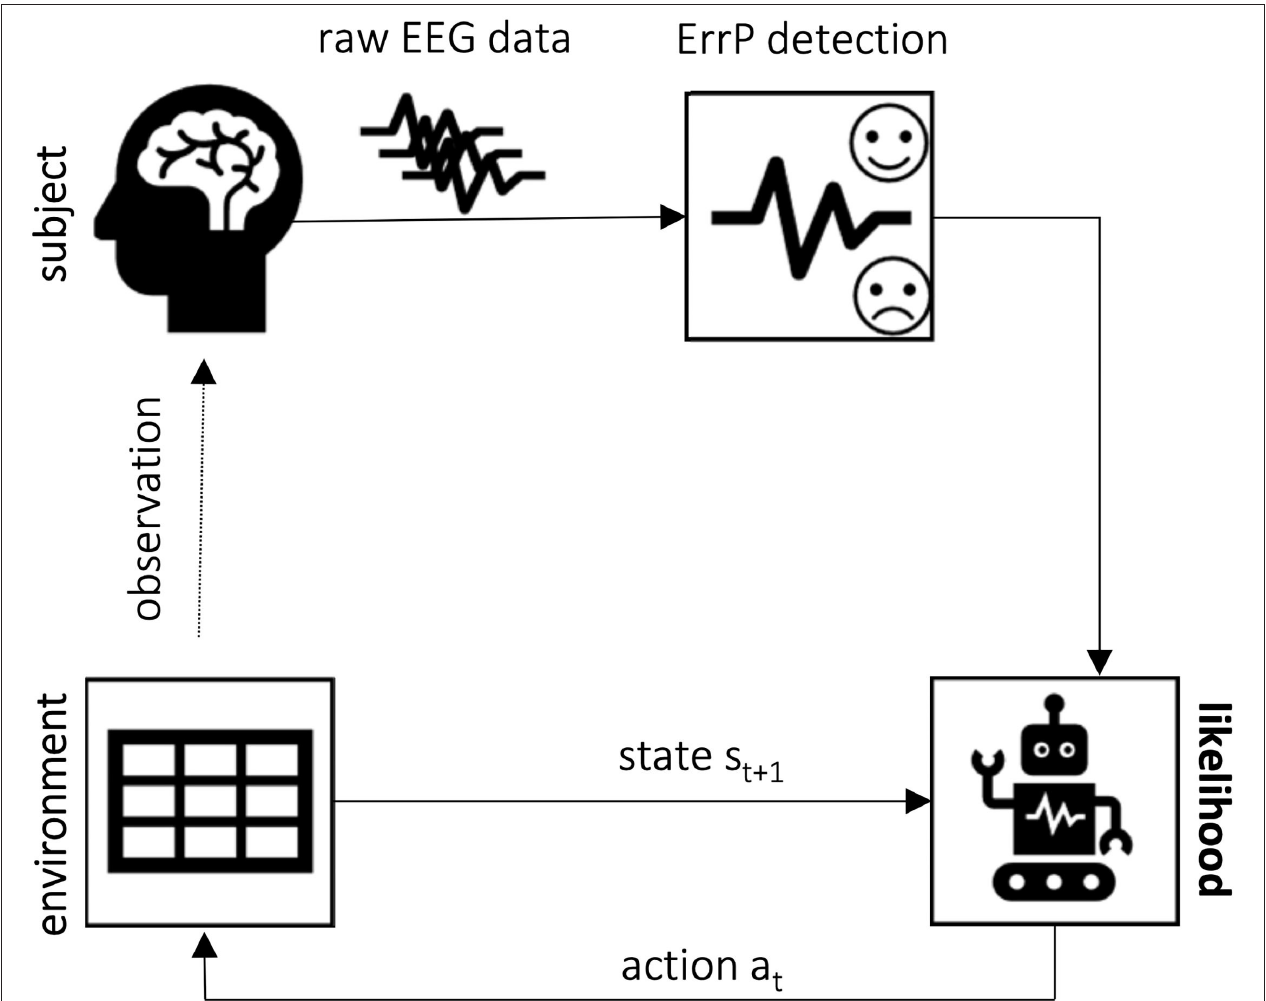
FIGURE 4 | Error-based learning framework concept: upon EEG data classification, the error information can be used to update the likelihood of, for example, performing each action, decreasing it upon error detected or increasing, otherwise. This approach has been used by Chavarriaga et al. (2007, 2010). Iturrate et al. (2015b), on the other hand, have used the error information to update the likelihood of each possible position being the desired